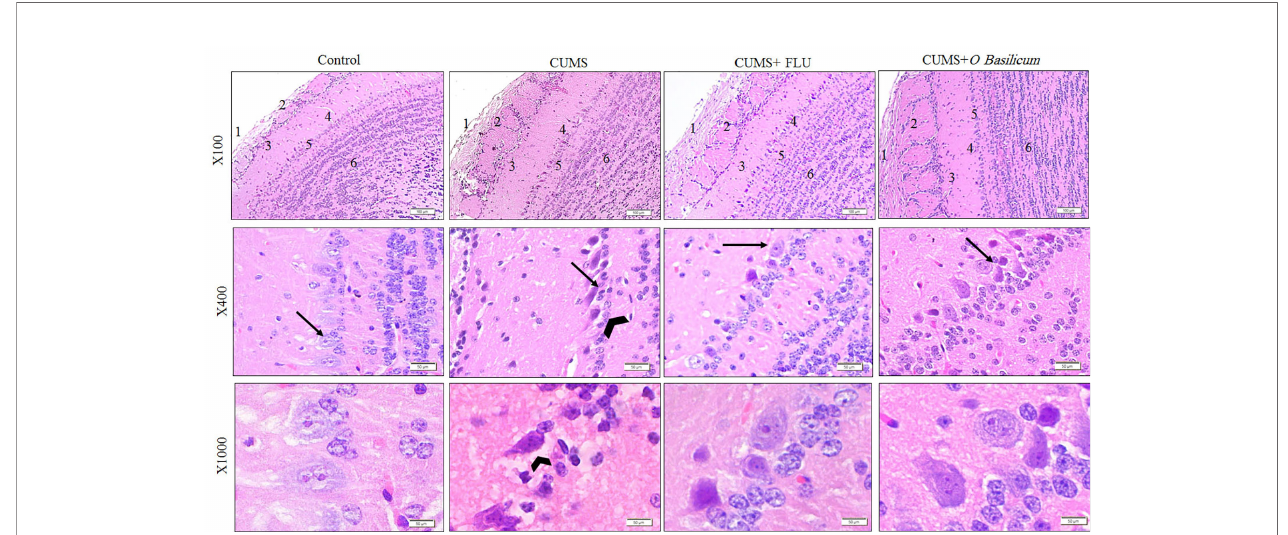
FIGURE 3 | The histological structure of the main olfactory bulb (MOB) of the studied groups show nerve fi ber layer (1), glomerular layer (2), external plexiform layer (3), mitral layer (4), internal plexiform layer (5), and granular layers (6). Note the affected mitral layer in the CUMS group appear with higher magni fi cation and show distorted and small Mitral cells (arrow) compared with other group together with widening of pericellular space around them (arrow head). H&E staining. CUMS, chronic unpredictable mild stress; FLU, fl uoxetine; O. basilicum , Ocimum basilicum